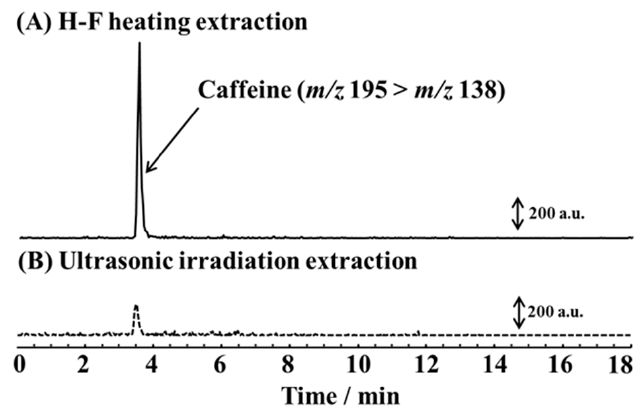
Figure 1. Selected reaction monitoring (SRM) chromatogram for caffeine in nails with ( A ) high-frequency (H-F) heating extraction (3 min; 220 °C) and ( B ) ultrasonic irradiation extraction (30 min). The sample mass was 10 mg and the extraction solvent volume was 200 μ L.